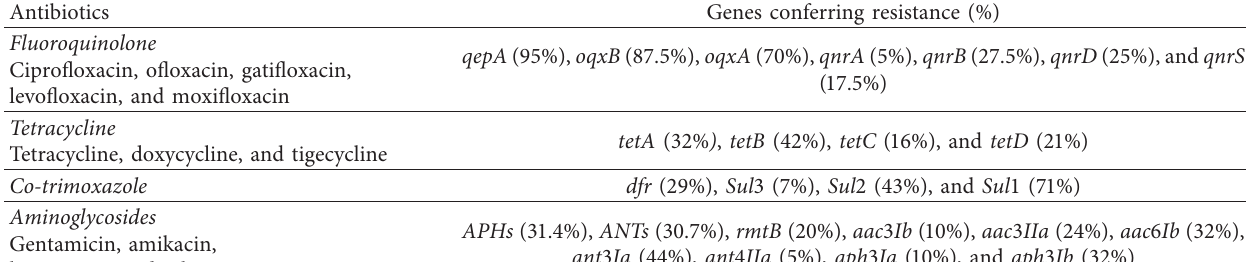
Figure 1: Antibiotic susceptibility testing by the agar dilution. CIP: ciprofloxacin; LEV: levofloxacin; GEN: gentamicin; KAN: kanamycin; TOB: Table 1: Distribution of antibiotic resistance genes in the current study. Genes conferring resistance